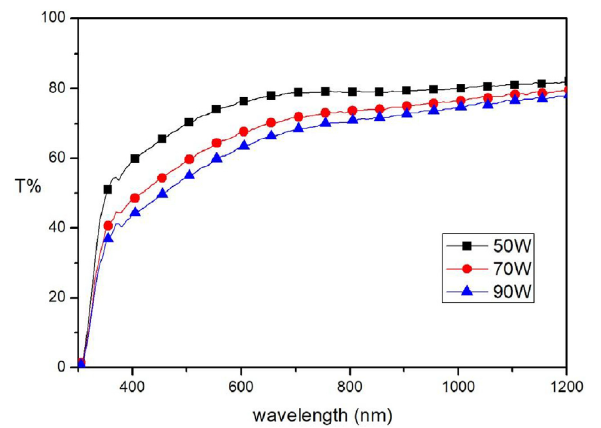
Figure 8. Evolution of the transmittance of SiC films in function of the RF power, measured by Wang [105]. Reprinted with permission from